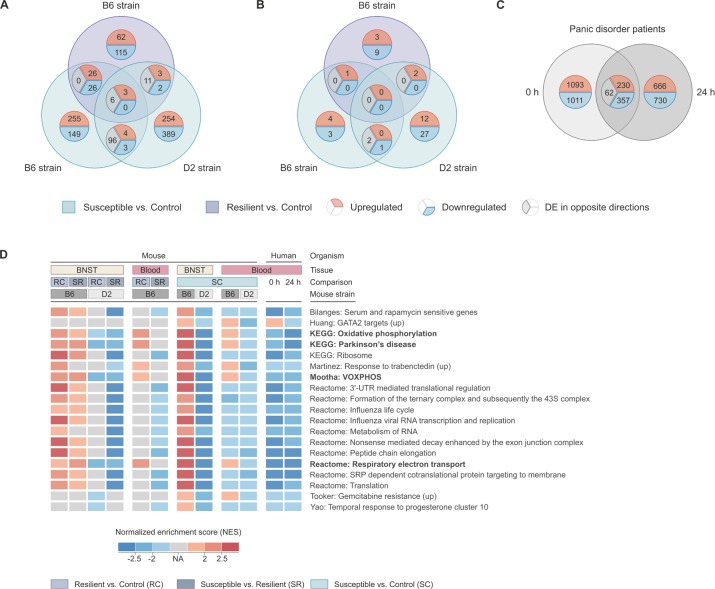
Converging analysis of blood cell gene expression data from stressed mice and panic disorder patients with exposure-induced panic attacks.(A-C) Venn diagrams showing overlap between significantly differentially expressed (A) mouse genes (data set F; P < 0.05 and |FC| ≥ 1.2), (B) mouse miRNAs (data set G; P < 0.05 and |FC| ≥ 1.2), and (C) genes (data set H; P < 0.05) in panic disorder (PD) patients’ blood cells. (D) Merged heatmap from gene set enrichment analysis showing the significantly enriched gene sets (PFDR < 0.25) present in at least 50% of all comparisons. Gene sets which did not pass the cut-off are marked in gray (NA). A positive (or negative) NES for a given gene set implicates its overrepresentation at the top (or bottom, respectively) of the ranked list of upregulated (or downregulated, respectively) genes. Gene sets are ordered alphabetically. B6: C57BL/6NCrl; BNST: bed nucleus of the stria terminalis; D2: DBA/2NCrl.